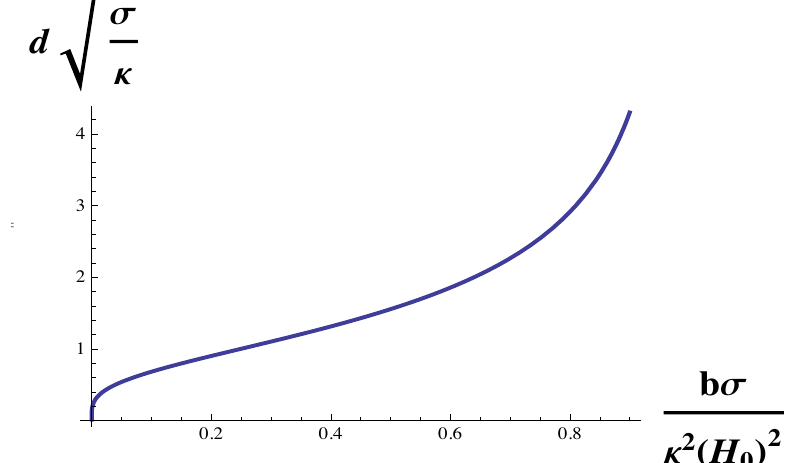
Figure 4. Domain size, d , in units of ( κ / σ ) 1/2 is plotted vs. b σ / κ 2 H 2 κ 2 H 2 / σ . The domain size diverges at the Lifshitz line, b σ / κ 2 H 2 0